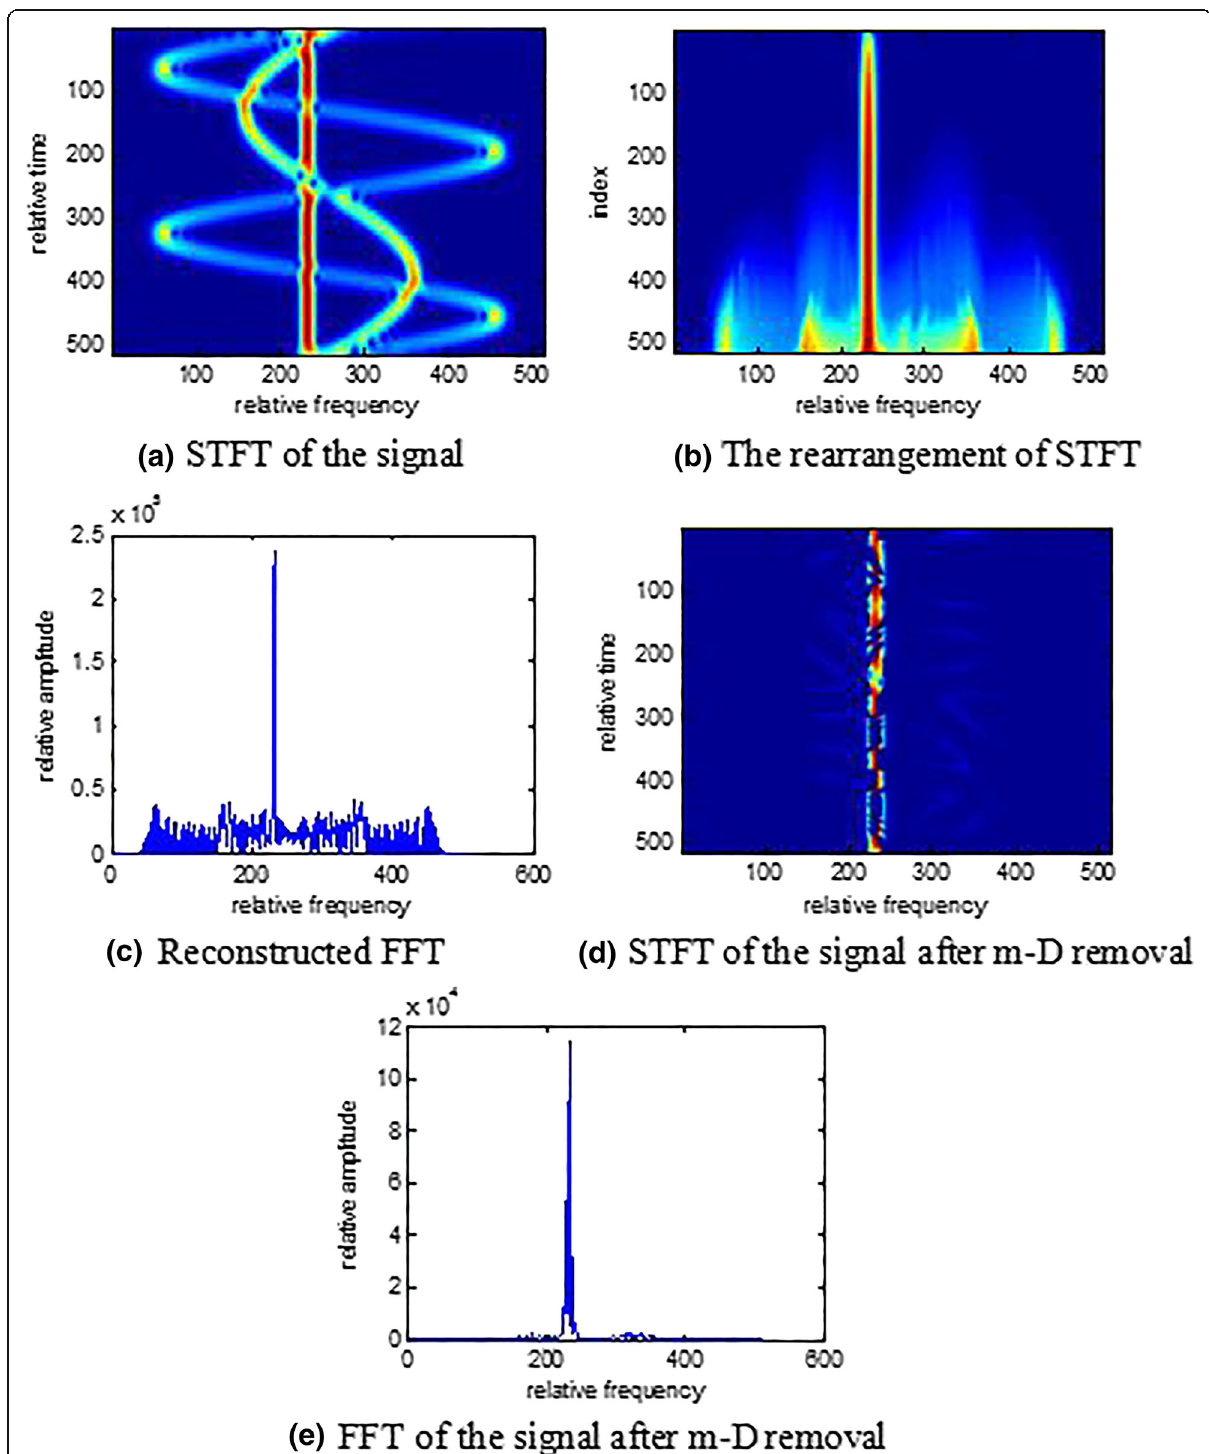
Fig. 3 Signal model simulation results. a STFT of the signal. b The rearrangement of STFT. c Reconstructed FFT. d STFT of the signal after m-D re- moval. e FFT of the signal after m-D